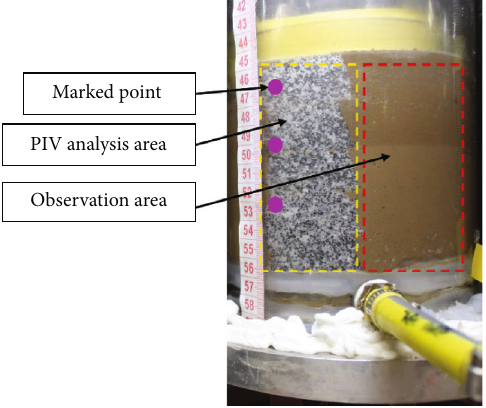
Figure 5: The soil column cylinder